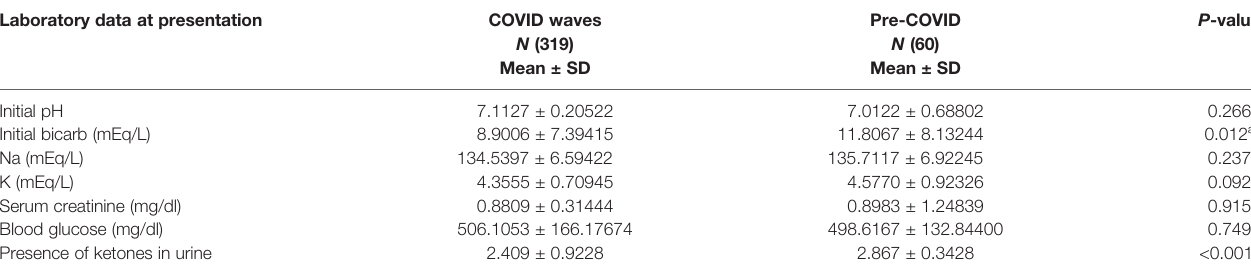
TABLE 4 | Comparison of data between the COVID-19 waves and